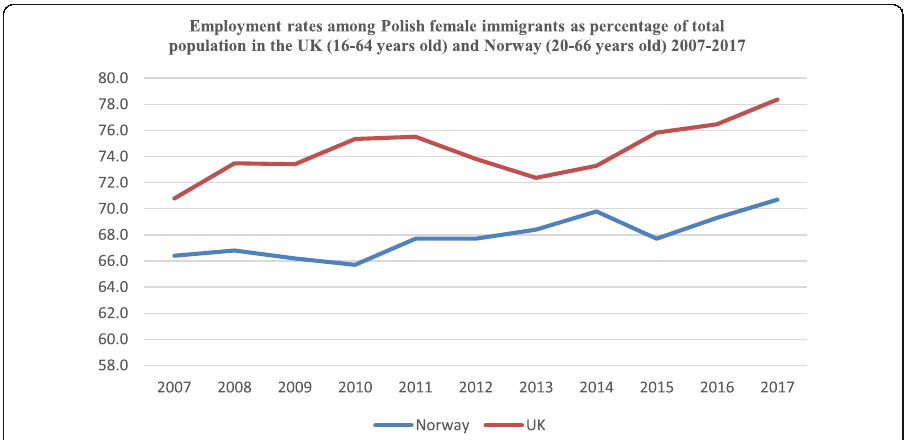
Fig. 1 Employment rates among Polish female migrants in the UK (16 – 64 years old) and Norway (20 –